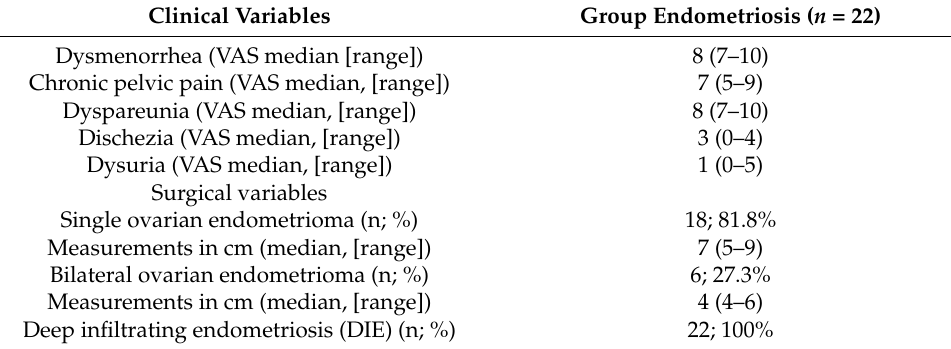
Table 1. Clinical data of the patients affected by severe endometriosis.